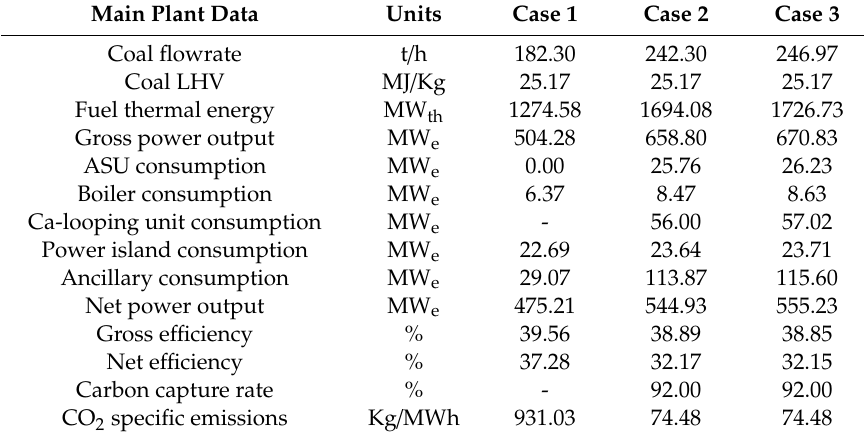
Table 2. Main technical power plant performance indicators (adapted from